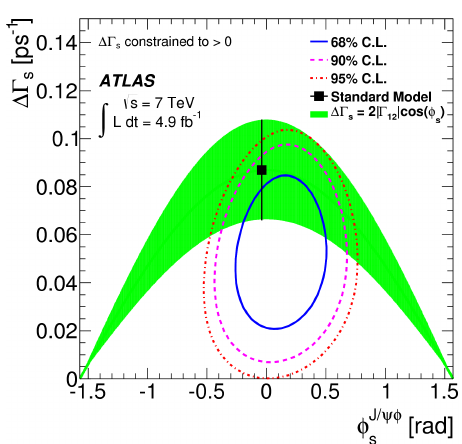
Figure 10: Likelihood contours in the φ s - ΔΓ s plane. The green band is the theoretical prediction of mixing-induced CP violation.